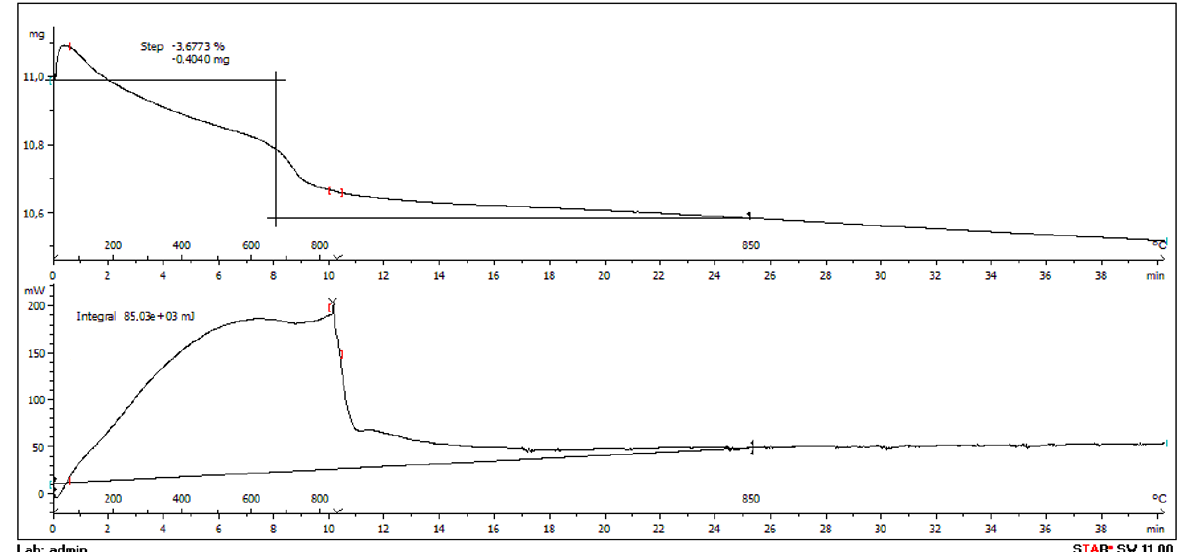
Figure 2. TGA-DSC Olivine/sand analysis.